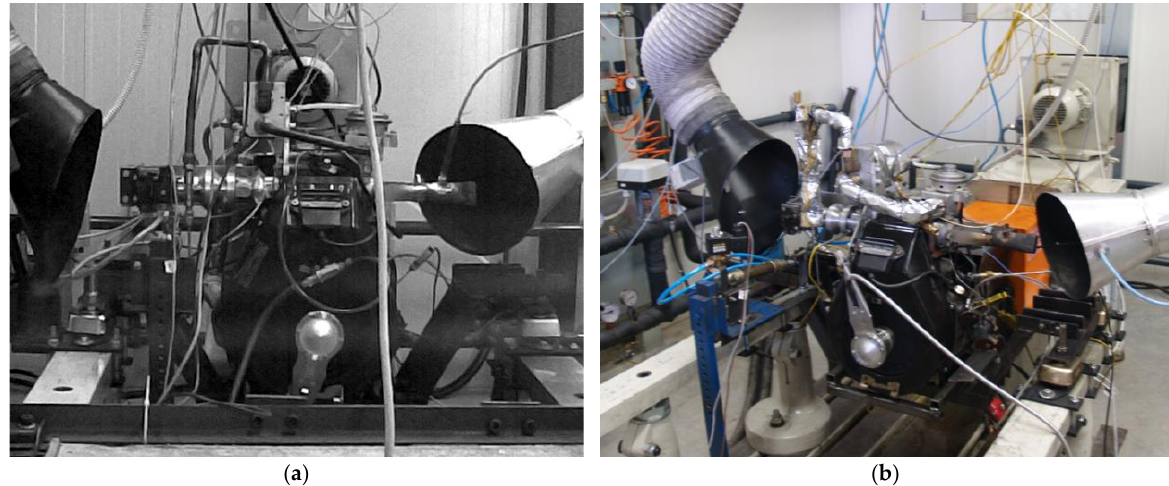
Figure 1. Frontal ( a ) and lateral ( b ) views of the Ruggerini RF51 engine installed at the APIcom RE100 test stand for the execution of the tests. Table 2. Main specifications about the used fuels.